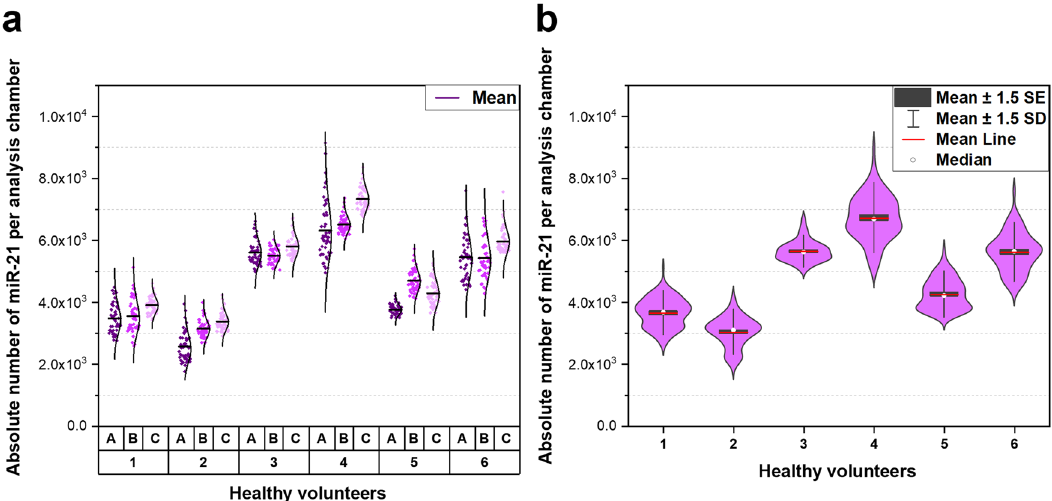
Fig. 6 Baseline expression of miR-21 was quanti fi ed in nasal fl uid collected non-invasively from six healthy volunteers. Nasal samples were collected using SAM. Nasal fl uid and cells was separated using centrifugation. Six volunteers (1 – 6) were sampled three times (A – C) within 7 days. Each nasal fl uid sample was analysed on separate micro fl uidic chips on the same day of sample collection. 30 µ L of nasal fl uid was introduced into the microchannel, miR- 21 molecules were diffused from the channel into analysis chambers for single molecule detection. Relative single molecule count of miR-21 was quanti fi ed using miR-21 calibration curve. a Distribution of miR-21 molecules expressed in each nasal fl uid sample. The different shades of purple represent three different nasal fl uid samples obtained from the same individual (A – C). b Violin plots comparing miR-21 expressed in nasal fl uid collected by different healthy volunteers. The box represents the SEM, and the whiskers represent 1.5x SD. Each box has the rotated kernel density plot on either side. Normal or gamma distribution curves were used to fi t the data to highlight the shape of each